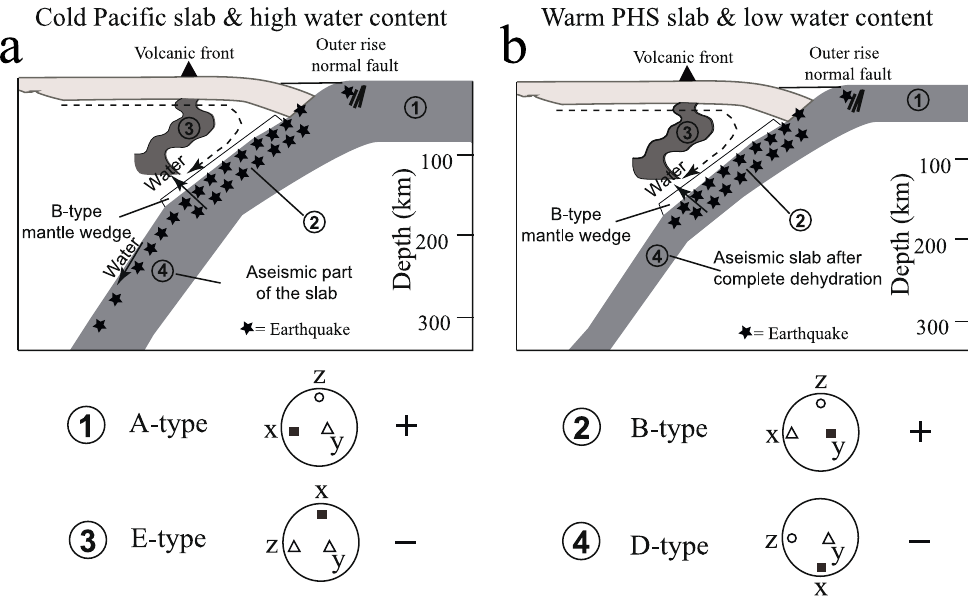
Figure 4. Schematic vertical cross-sections depicting relations between seismic anisotropy, water migration, and double seismic zone in cold ( a ) and warm ( b ) subduction zones. They show the anisotropic structures of the subducting slabs (marked by 1, 2 and 4), the overlying B-type mantle wedge, and the hot mantle upwelling associated with arc volcanism (marked by 3). The dashed arrow denotes the slab-driven corner flow direction. The solid arrow denotes water migration induced by dehydration embrittlement of hydrous materials in the slabs. Possible types of olivine fabrics in different parts are also shown. In each of the big circles below the vertical cross-sections, the solid square, open triangle and open circle denote the directions of the maximum, intermediate and minimum P-wave velocities, respectively. The two open triangles in the circle ③ denote that the axis directions and amounts of the intermediate and minimum P-wave velocities cannot be distinguished by this study. The plus ( + ) and minus ( − ) symbols beside the big circles denote positive and negative radial anisotropies, respectively. The velocity features for the types of olivine fabric are derived from the previous studies 17, 40 . This figure is generated by free and open source INKSCAPE 0.91